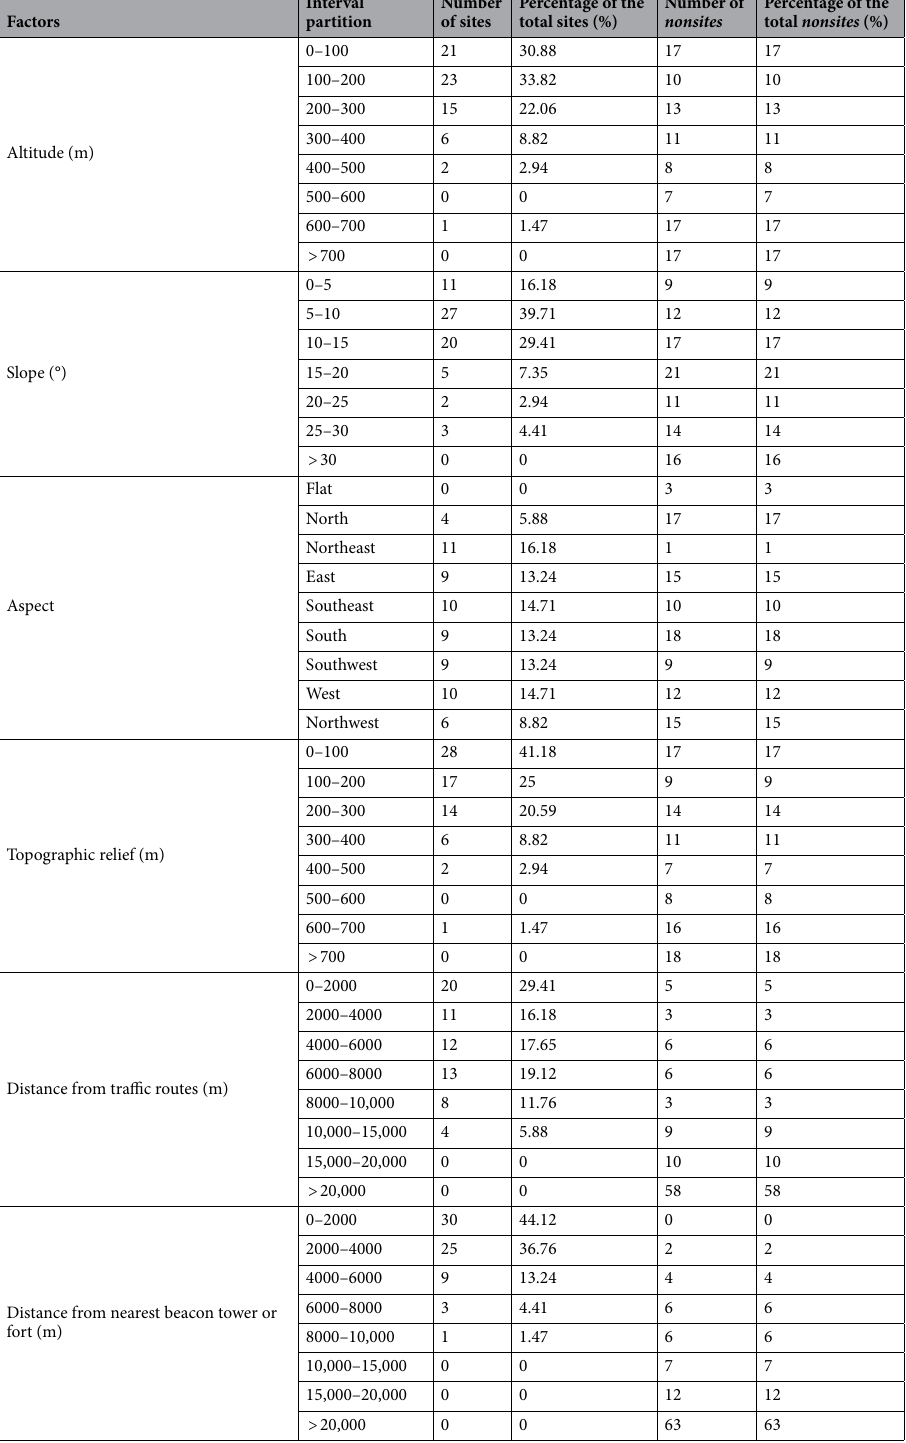
Table 2. Beacon sites and nonsites distribution